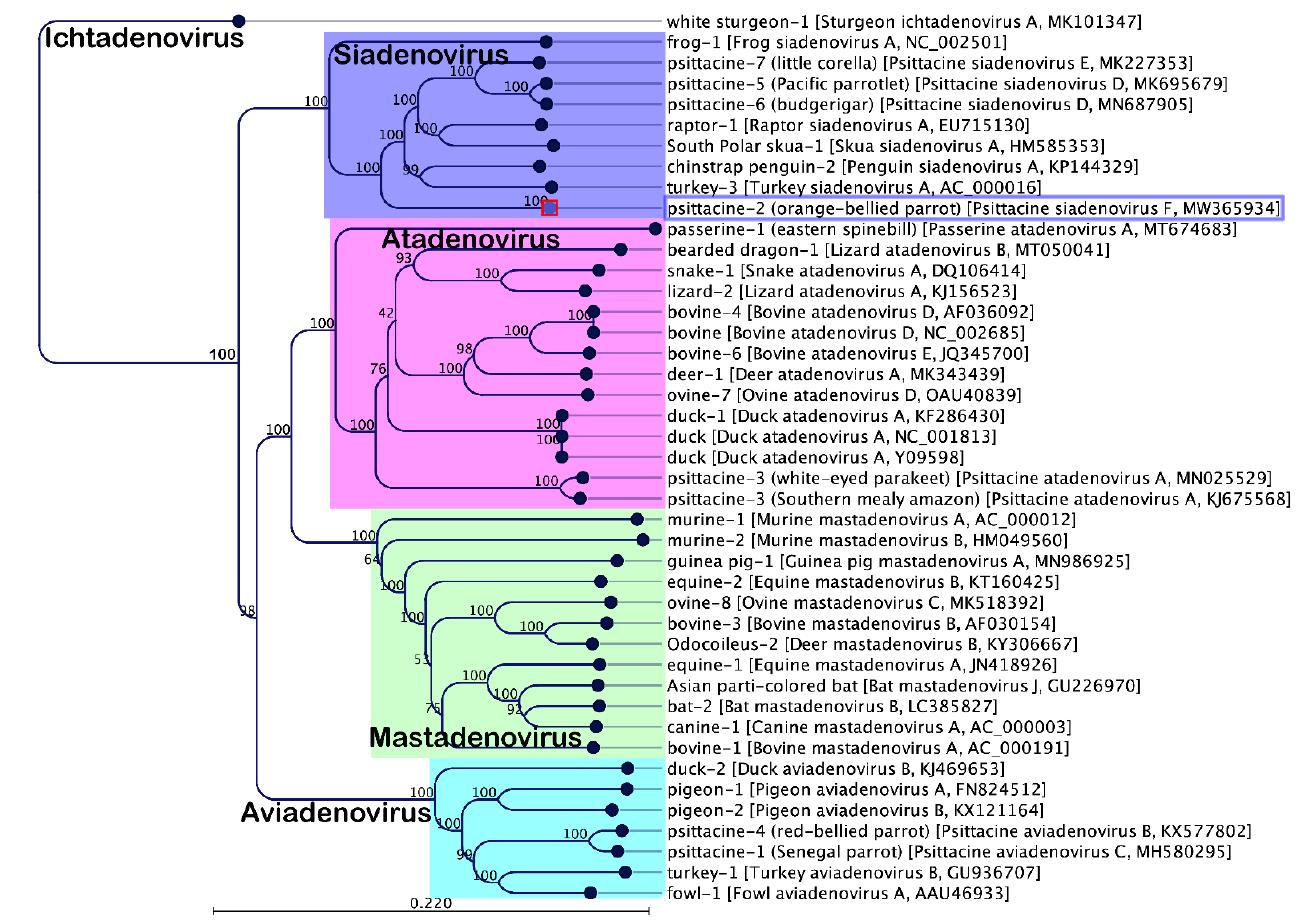
Figure 2. Phylogenetic tree shows the possible evolutionary relationship of novel psittacine siadenovirus F with other selected AdVs. A maximum likelihood (ML) tree was constructed using concatenated amino acid sequences of the complete DNA-dependent DNA polymerase, pTP, penton, and hexon genes. Concatenated protein sequences were aligned with MAFTT (version 7.450) [33] in Geneious (version 20.0.3, Biomatters, Ltd., Auckland, New Zealand) under the BLOSUM62 scoring matrix and gap open penalty = 1.53. The gap > 20 residues were deleted from the alignments. The unrooted ML tree was constructed under the WAG substitution model, and 1000 bootstrap replicates were constructed using tools available in CLC Genomics Workbench (version 9.5.4, CLC bio, a QIAGEN Company, Prismet, Aarhus C, Denmark). The numbers on the left show bootstrap values as percentages, and the labels at branch tips refer to original host species followed by AdVs name and GenBank accession number in parentheses. The novel psittacine siadenovirus F is shown in the purple-coloured box.